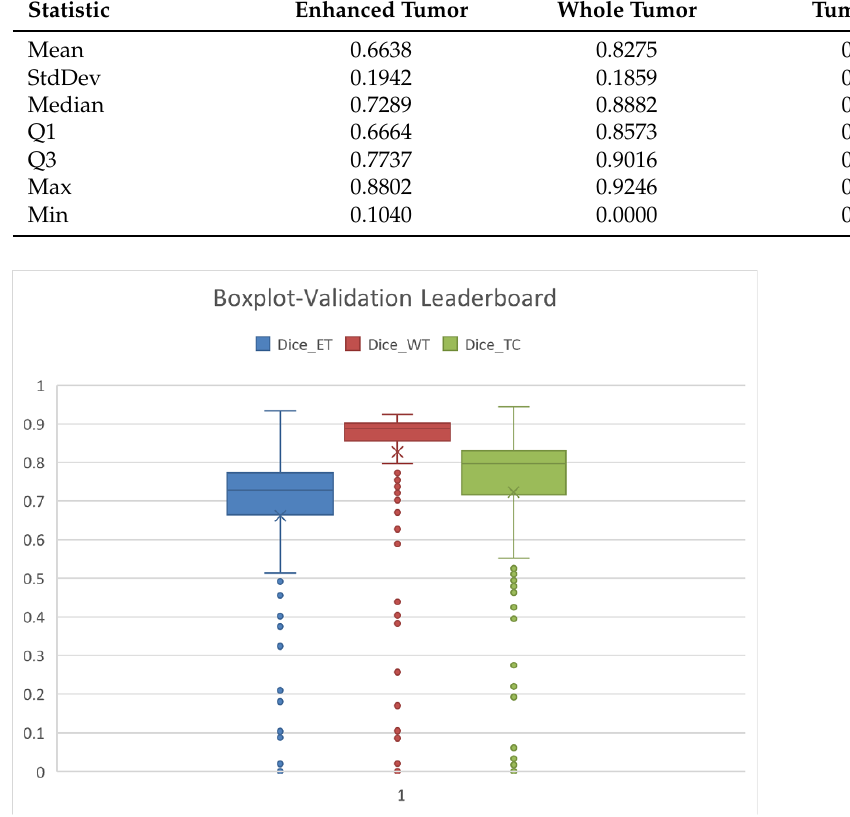
Figure 13. Leaderboard Dice Scores for ET, WT, and TC: the mean is denoted by X, the median is the center-line of the box, and Q1 and Q3 are the top and bottom edges of the